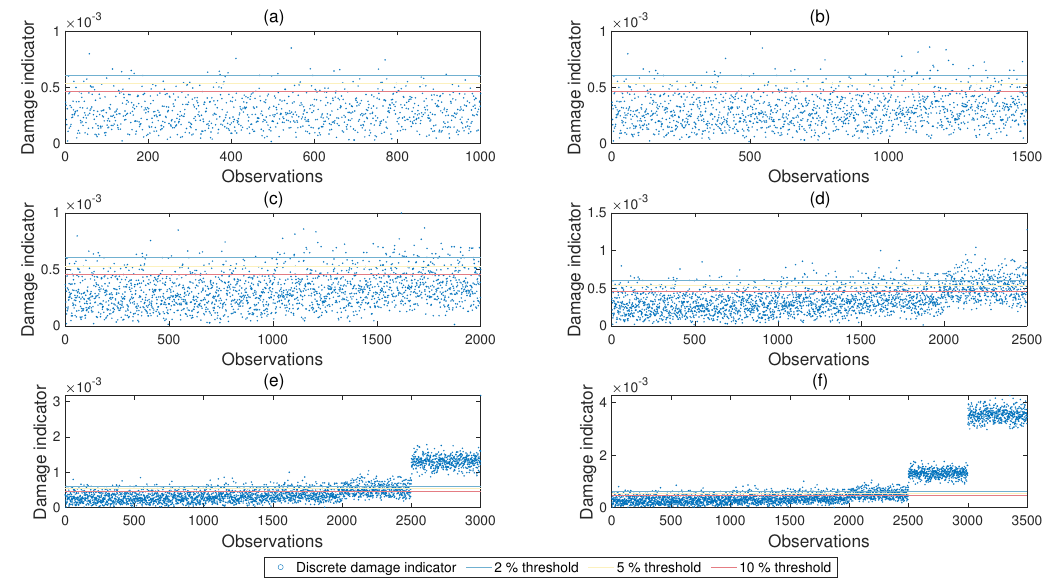
Figure 6. Scatter plot of the modal curvature damage indicator at sensor 3 for damage at the mid-span; 5% noise. Subplots ( a – f ) show the development of the scatter plot from the first 1000 observations to 3500 observations. The damage level increases with the observation number as summarized in Figure